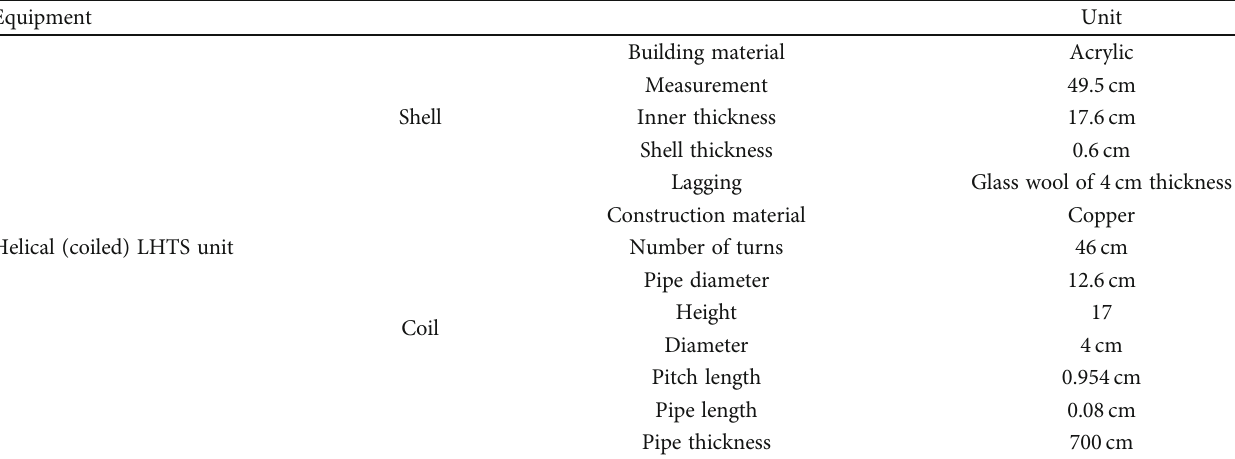
Table 1: Speci fi cation of LHTS